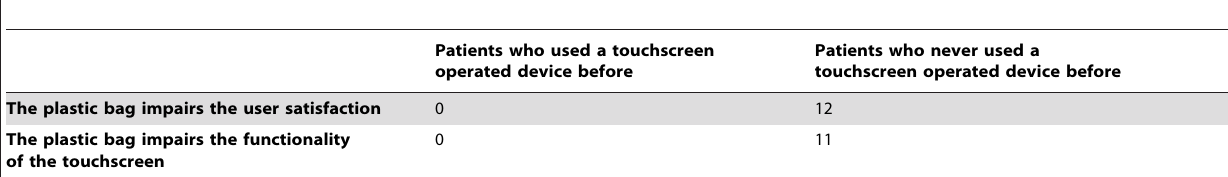
Table 5. Convenience for the operators and functionality of the touchscreen using a plastic bag-covered tablet computer dependent on the experience of participants with touchscreen operated devices (n =